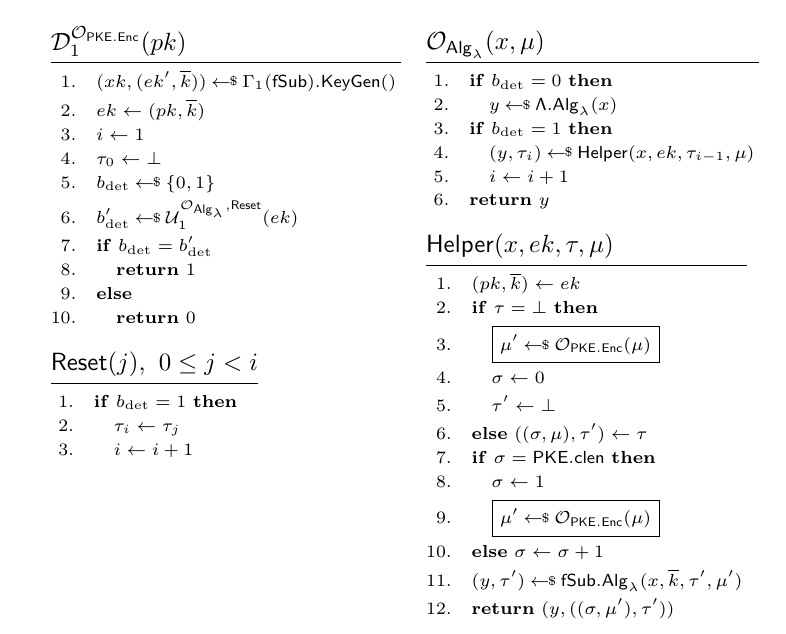
Figure 17: Adversary D 1 for the proof of Theorem